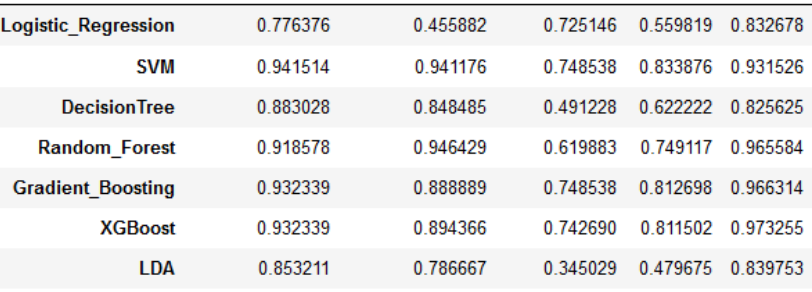
Figure 9. Performance measurement chart.